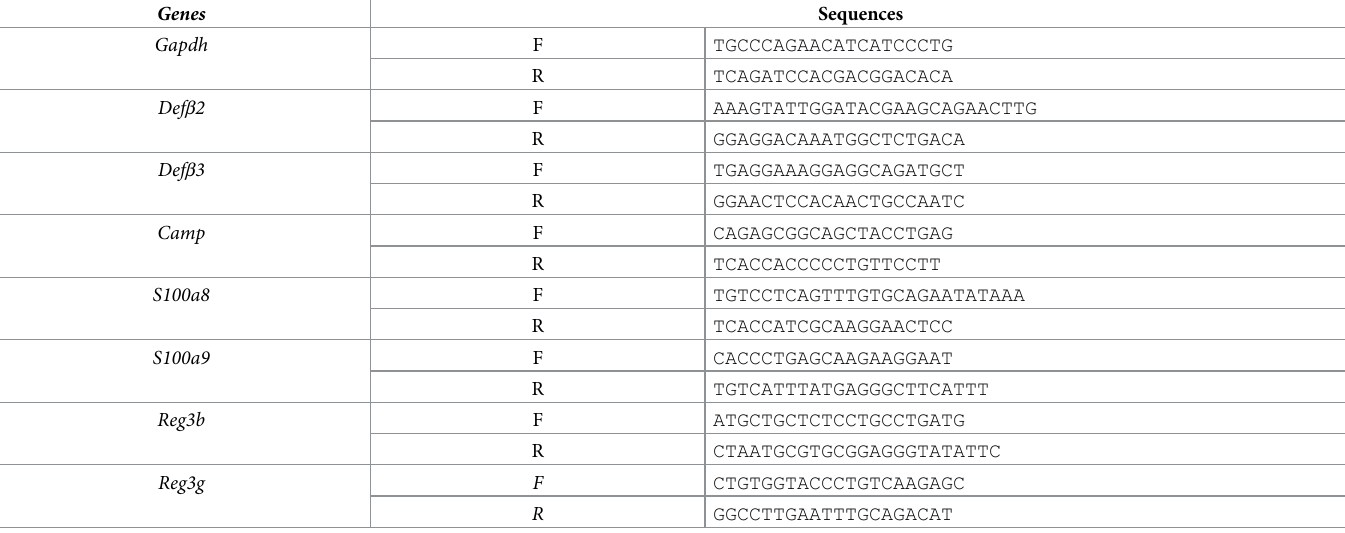
Table 3. Primer sequences for qRT-PCR in mice. Forward (F) and reverse (R) primers are cited.